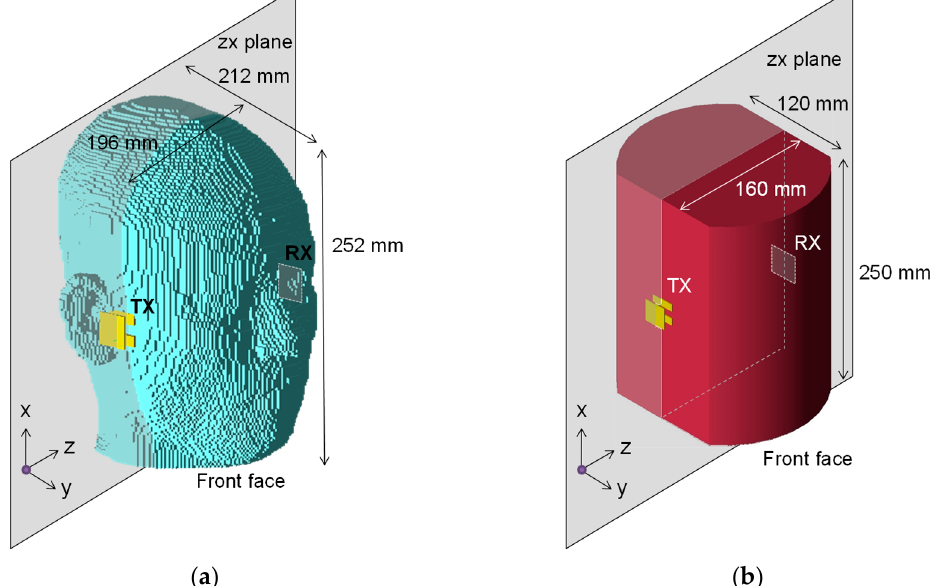
Figure 3. Two simplified models: ( a ) detailed head model and ( b ) homogenous ‐ muscle head model.